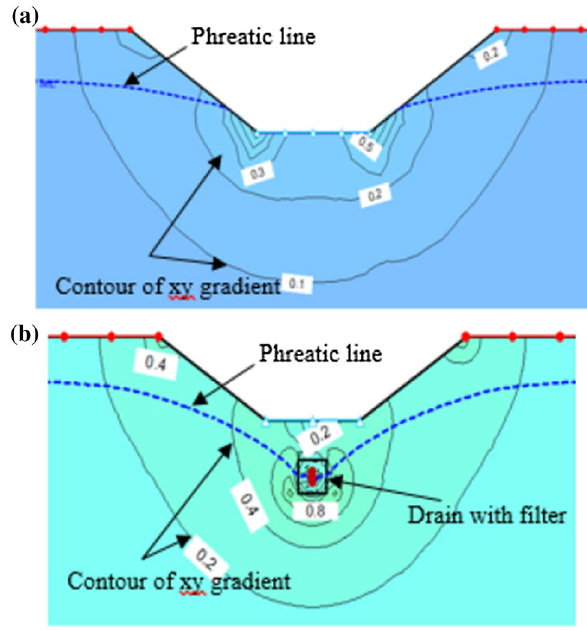
Fig. 12 Contours of hydraulic gradient a without a drain and fil- ter, H = 20.8 m, b with a drain and filter, H = 20.8 m, D = 0.2 m, Y = 19 m, t = 0.25 m